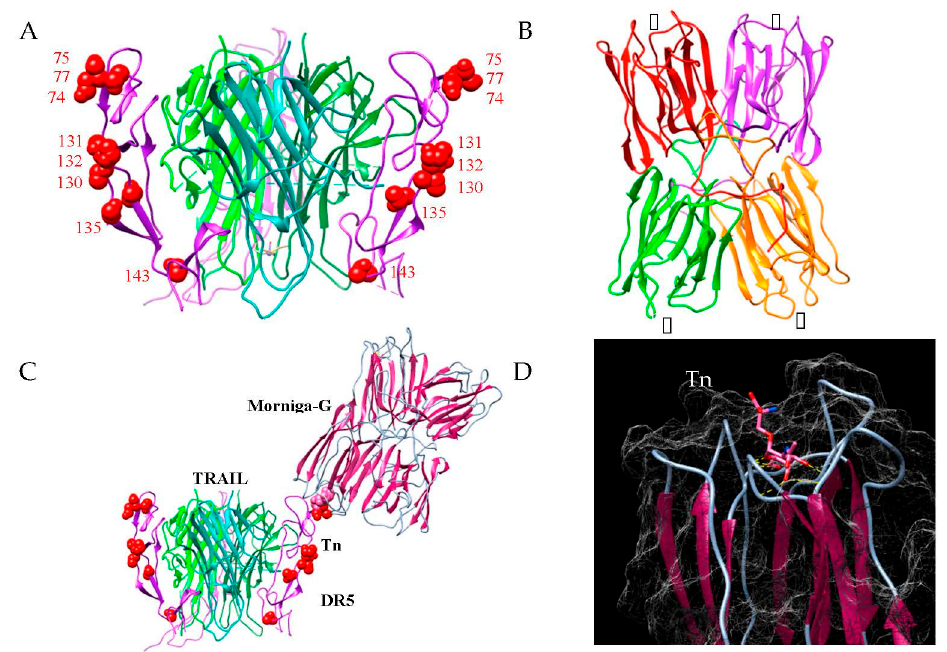
Figure 6. Morniga-G might interact with Tn antigens presented by DR5 receptor. ( A ) Mapping of O -glycosylation sites (Ser and Thr residues) on the crystallographic complex of the TRAIL trimer (green colors) with DR5 (purple), PDB code 1DU3 [18]. Ser residues 74, 75, 77, and Thr residues 130, 131, 132, 135, and 143 are represented in red spheres. ( B ) Three-dimensional model built for Morniga-G, made of four protomers, each containing a Tn-specific binding site ( ). ( C ) Cartoon showing the interaction between Morniga-G and the DR5 receptor complexed to its natural TRAIL ligand, via the recognition of Tn antigen located on Ser residue 75. ( D ) Docking of Tn antigen to the Tn-specific binding site of Morniga-G. Yellow dashed lines indicate the network of hydrogen bonds connecting Tn antigen to the lectin.